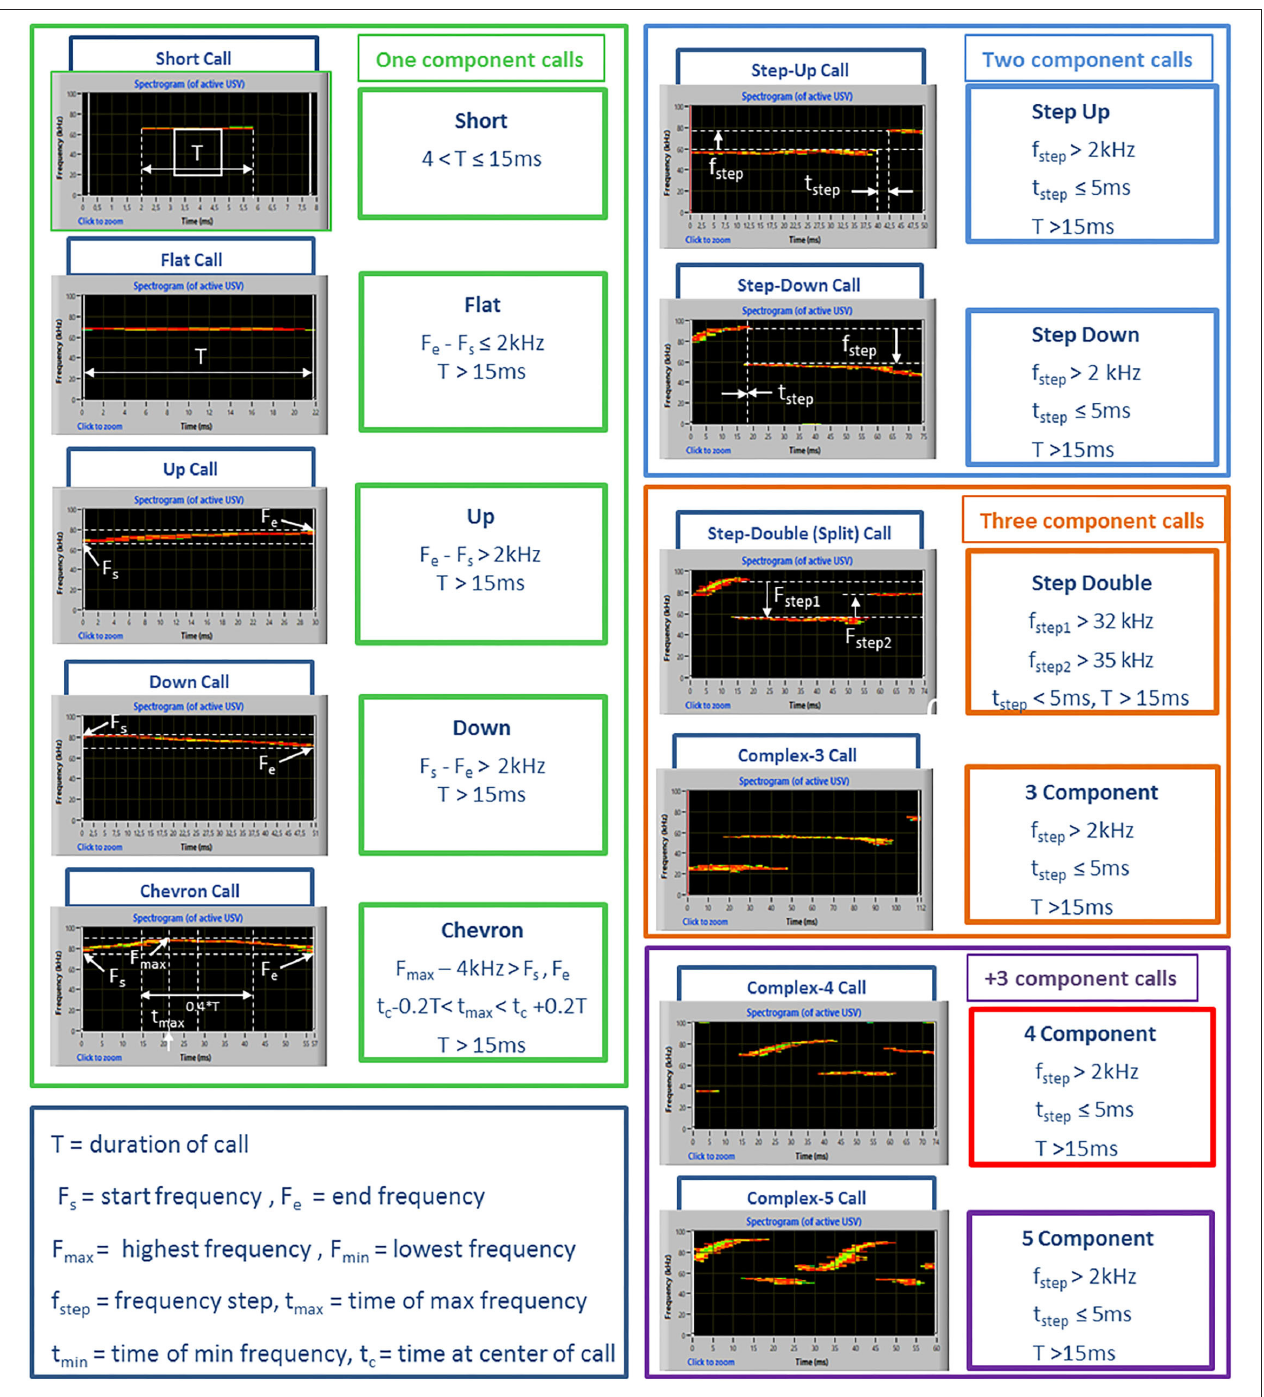
FIGURE 1 | Examples of ultrasonic call types used to classify USVs in the study. The call types were automatically classified using the software Sonotrack and based on the parameters described above. Definitions of the call types were mutually exclusive. Overlap of components was removed when more than 70 % to prevent wrong call durations. Short gaps between components in both frequency ( ≤ 6kHz) and time ( ≤ 5ms) were interpolated (gaps can be caused by changes in microphone sensitivity or direction of vocalization). Complex “3 component” and “ + 3 component” calls were summed up into a “complex tot” category.